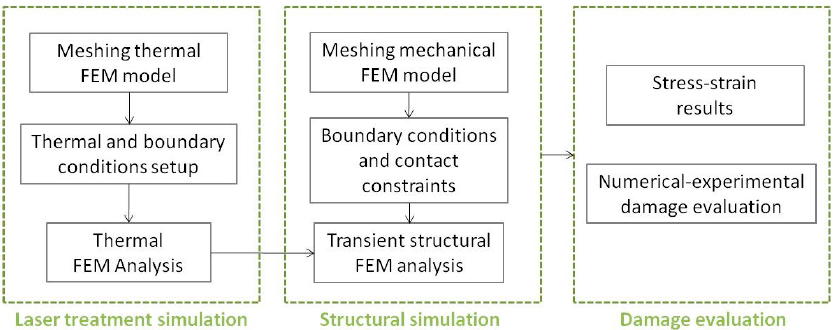
Figure 3. Flowchart of the proposed finite element model (FEM) procedure.